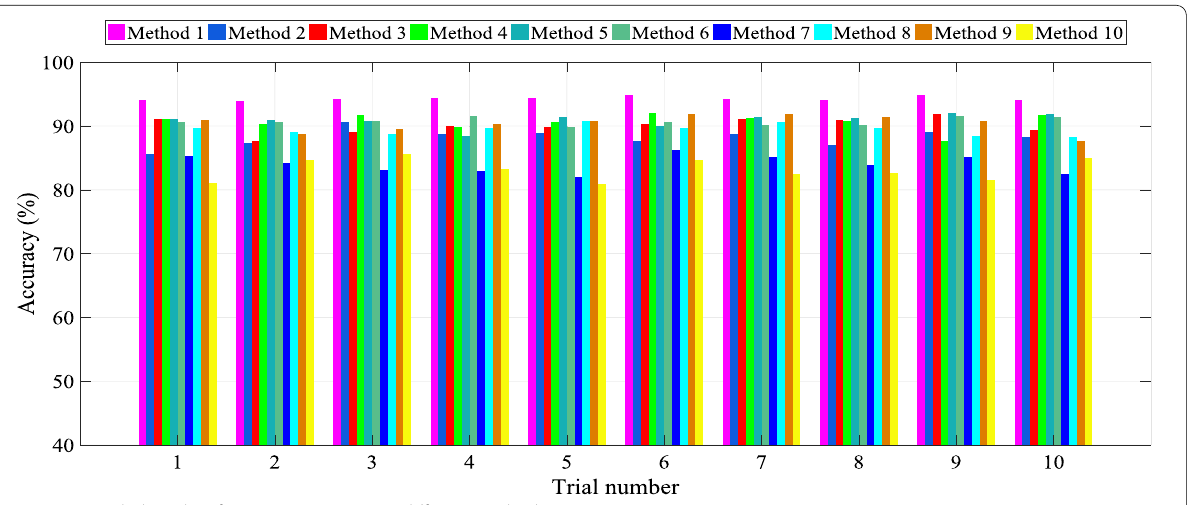
Figure 9 Detailed results of 10 experiments using different